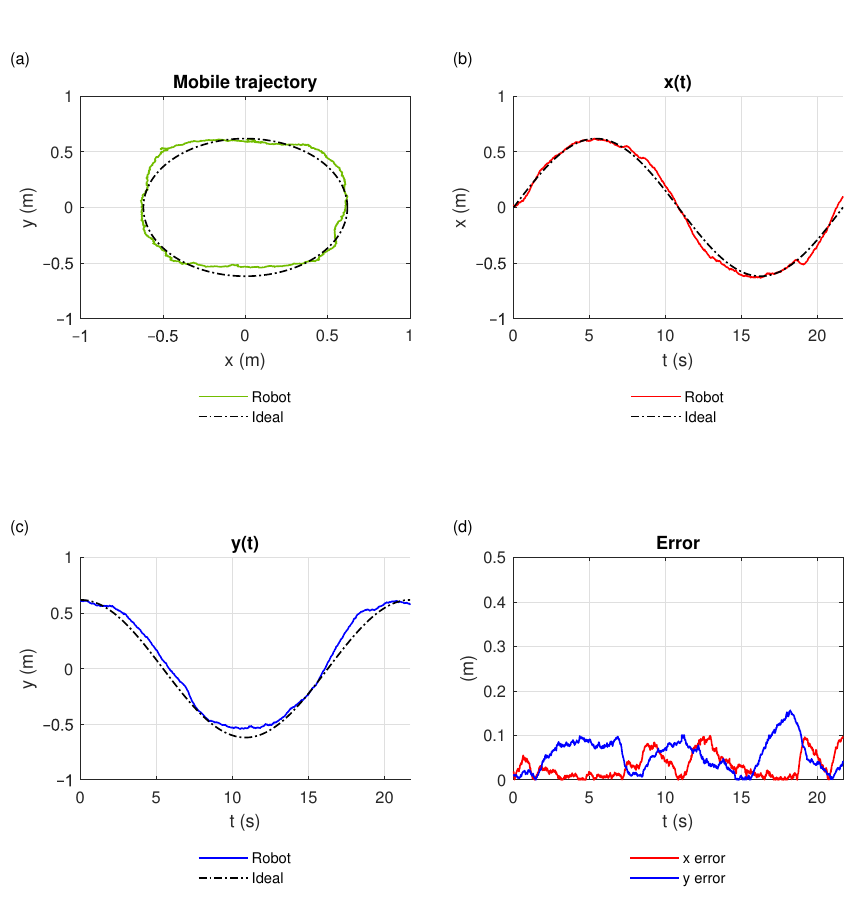
Figure 10. Results of the characterization run for a 2 × 2 m workspace. ( a ) Trajectory performed by the robot. ( b ) x -axis component of the movement. ( c ) y -axis component of the movement. ( d ) Quadratic error on x and y between the performed path and the given ideal